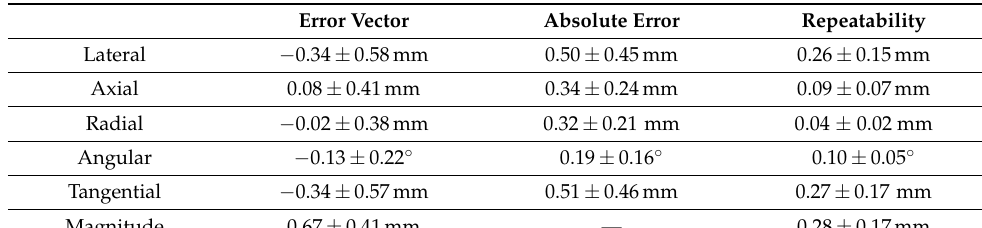
Table 1. Magnitude and directional components of the spatial-mean and spatial-standard-deviation of tracking error and repeatability measured in the homogenous medium (water). The tangential direction is orthogonal to the radial direction.